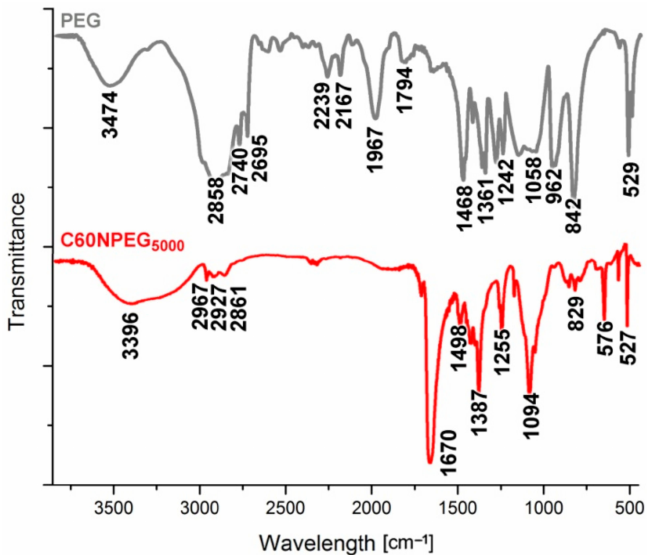
Figure 3. FTIR spectrum of C60NPEG 5000 (red line) and unmodified PEG (grey